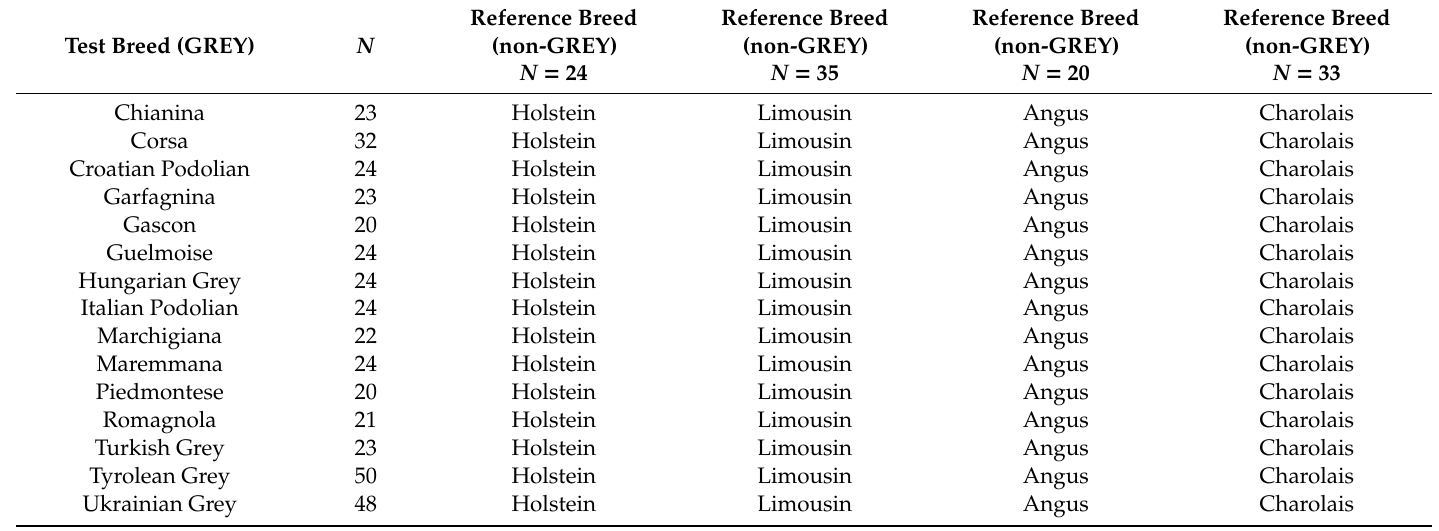
Table 1. Outline of the experimental design. N, number of genotyped animals.